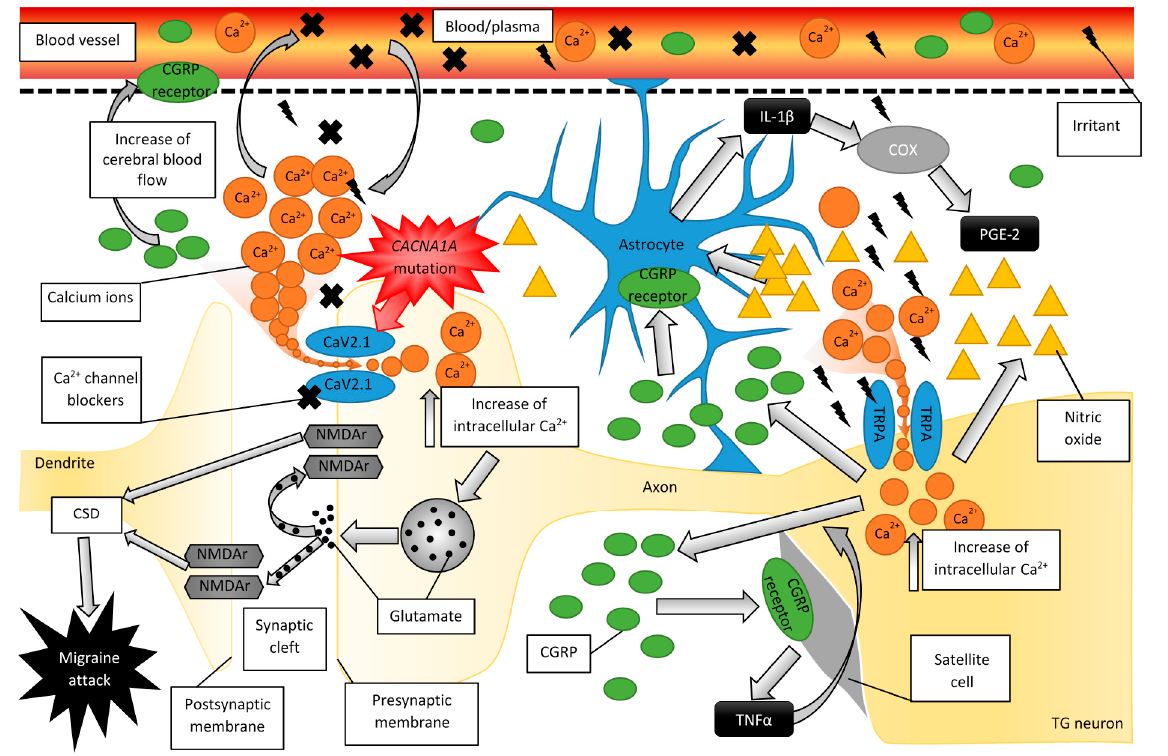
Figure 2. Induction of migraine attack due to sensitization of trigeminal ganglia and disturbed glutamatergic release. TRPA1 receptors in sensory neurons in trigeminal ganglia (TG) activate under environmental irritants taken by inhalation, ingestion or in an unknown mechanism. Activation of the TRPA1 receptor stimulates the release of calcitonin gene-related peptide (CGRP) that may enter bloodstream during migraine attack. CGRP receptor is expressed by majority on the neurons forming myelinated TG A-fibers, as well as on smooth muscles of dura’s vasculature. CGRP receptor stimulation increases blood flow. Besides CGRP, activated TG neurons secrete nitric oxide (NO). These mediators stimulate further the surrounding glial cells to produce interleukin-1 β (IL-1 β ) that in turn leads to increased activity of cyclooxygenase (COX), associated with production of proinflammatory prostaglandin E2 (PGE2). This phenomenon may be one of foundations of the TG neurons sensitization. Subsequently, CGRP released by TG neurons may also promote release of tumor necrosis factor- α (TNF- α ) in the glial satellite cells. That may cause a positive feedback loop of further TG-neuronal synthesis and secretion of CGRP. Furthermore, the released TNF- α may itself sensitize TG neurons and inflict overproduction of various other proinflammatory cytokines. Activation of TRPA channels increase the intracellular calcium ion levels (Ca 2+ ), similarly to L-type of Voltage Gated Calcium Channel (CaV2.1). Mutations in CACNA1A gene lead to enhanced Ca 2+ currents. The enhanced Ca 2+ influx lead to excitation-inhibition imbalance and enhanced glutamate release. The interaction between glutamate and pre- and postsynaptic glutamate NMDA receptors (NMDAr) may facilitate the cortical spreading depression (CSD)—believed as one of the causes of migraine attack. Ca 2+ channel blockers affect the CaV2.1 channels and reduce excessive Ca 2+ influx to the cells, normalizing glutamate release and thus may be also used in the treatment of migraine